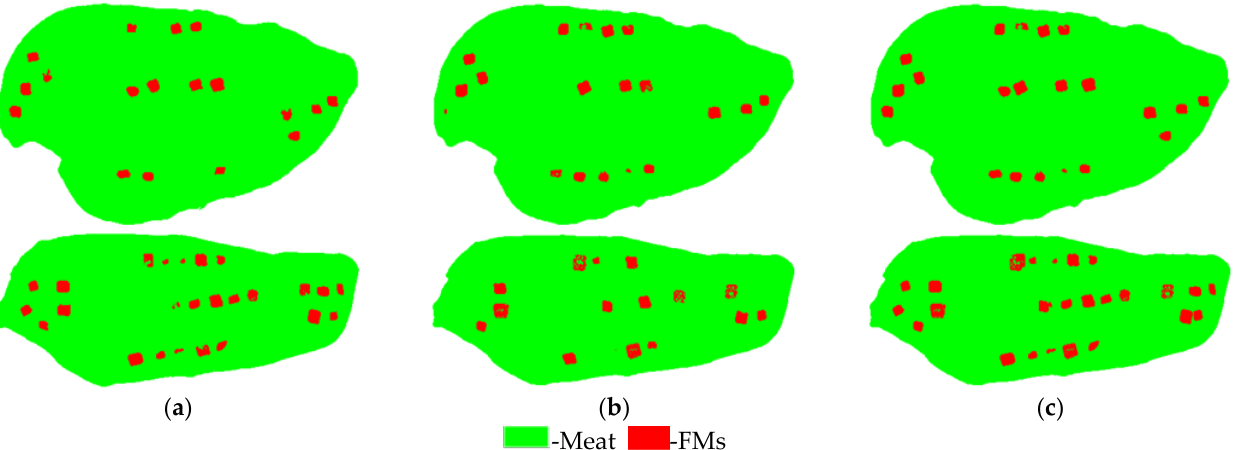
Figure 7. Classification images with ( a ) VNIR model only, ( b ) SWIR model only ( c ) developed fusion algorithm on the training set: Fusion + VNIR + SWIR. Green color represents chicken meat and red color represents FMs.